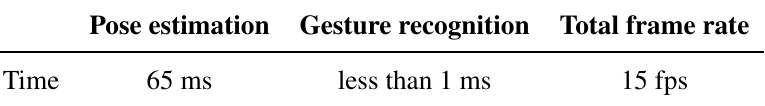
Table 1. Average computation times of the proposed